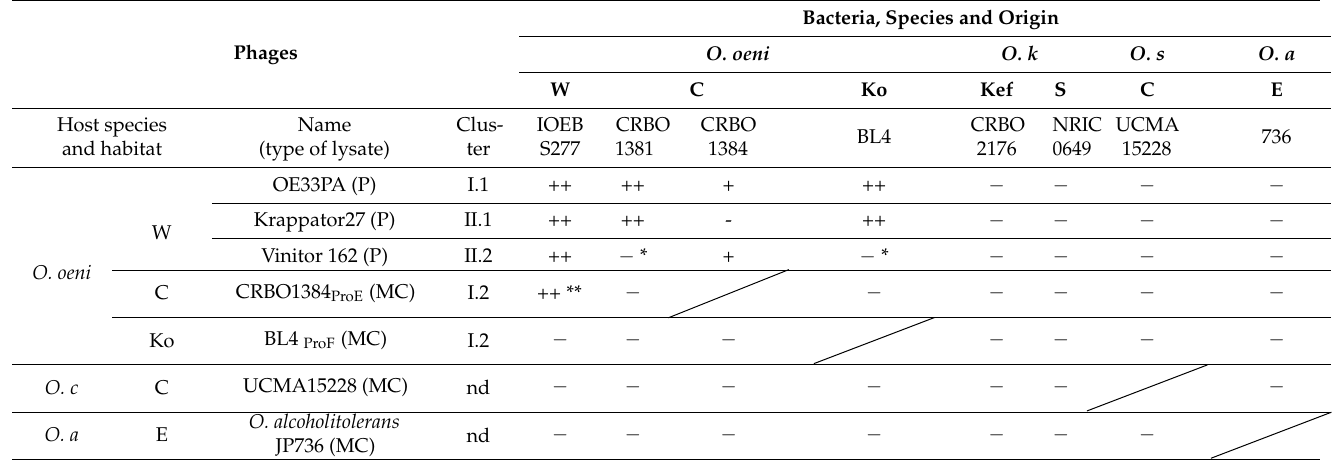
Figure 5. Variability of the protospacer sequences incorporated as SP OSI 78, SP OSI 89 ( A ) and SP OSII 1 ( B ) in oenophages. Analysis of the Rep5 proteins in Vinitor 23 and its homologue in Vinitor 162 ( C ). The variable region marked in red results from the deletion of the protospacer matching SP OSII 1 in Vinitor 162. Table 3. Interactions between phages and members of the Oenococcus